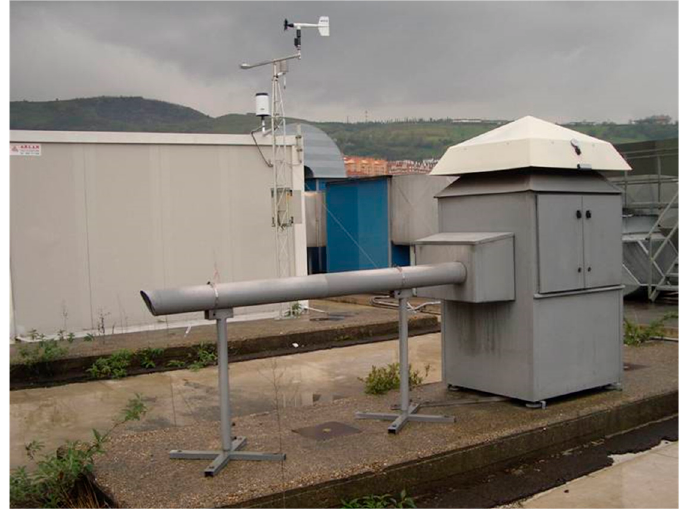
Figure 2. Photography of the sampling place on the roof of the Faculty of Engineering.